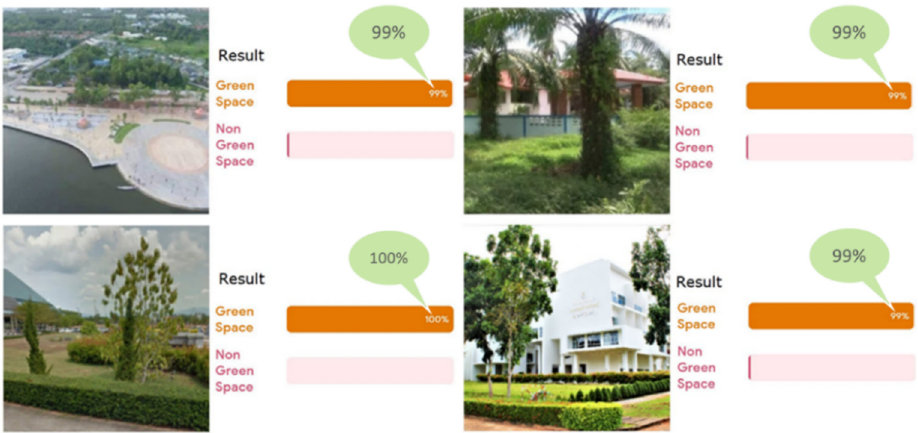
Figure 4. Examples of deep learning classification of green space areas. Note: for clarity, callout balloons are added in this paper but are not present on the actual web page.